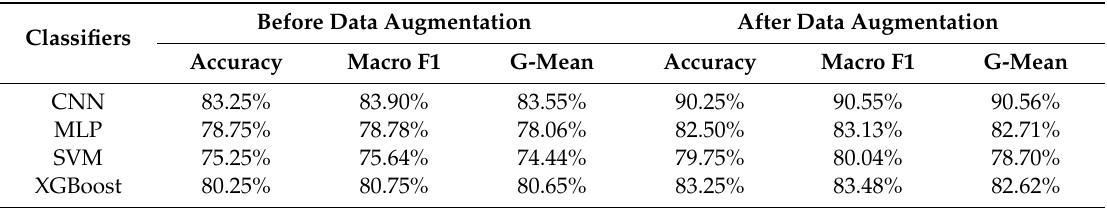
Table 5. Results of the test set using di ff erent